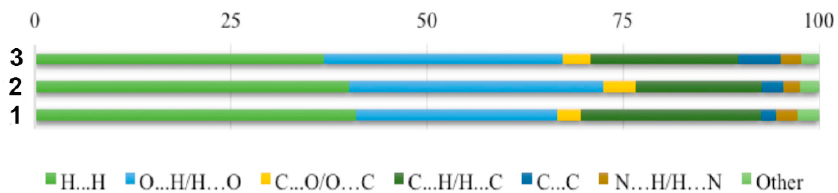
Figure 11. Relative contributions to the Hirshfeld surfaces for the major intermolecular contacts in 1 - 3 .